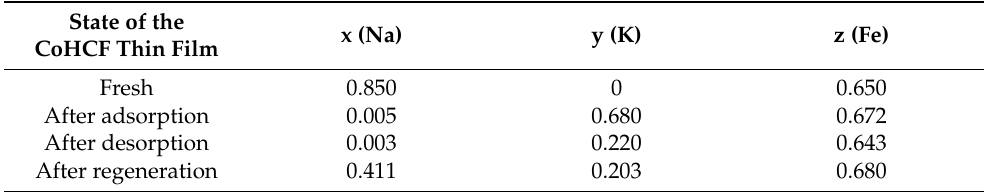
After desorption After